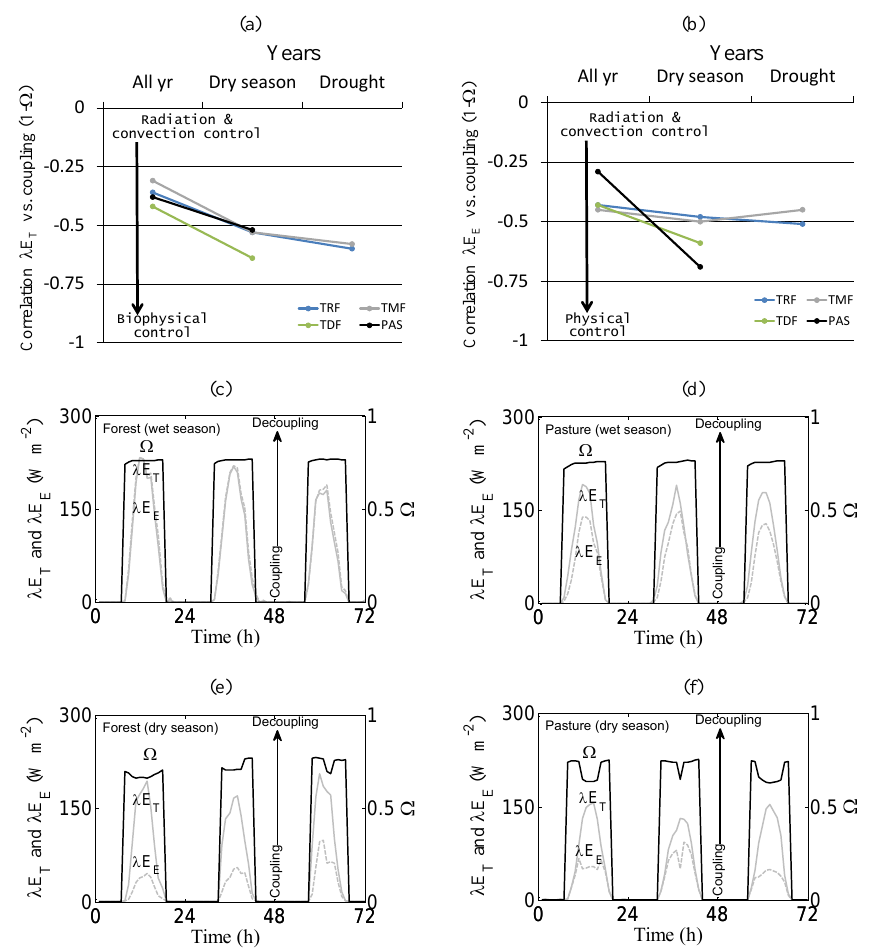
Figure 5. Correlation of coupling (1 − (cid:127) ) with (a) transpiration ( λE T ) and (b) evaporation ( λE E ) and over four different PFTs by combining data for all the years, only during dry seasons for all the years, and during drought year 2005. Data for 2005 were not available for TDF and PAS. (c) – (e) Examples of the diurnal pattern of (cid:127) (black lines), λE E (grey dotted lines) and λE T (grey solid lines) estimated over two ecohydrologically contrasting biomes (K34 for forest and FNS for pasture) in the Amazon Basin (LBA tower sites) during wet and dry